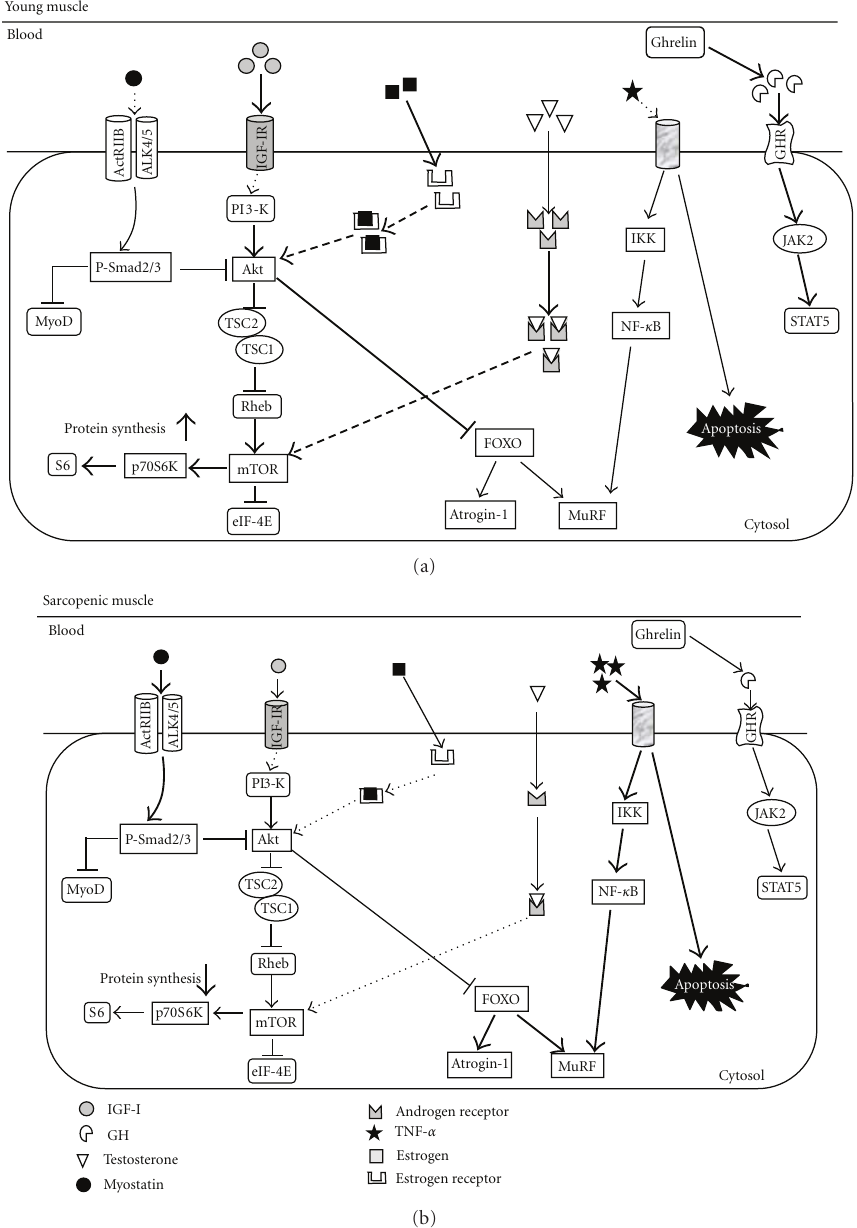
Figure 1: (a) In young muscle, abundant serum IGF-I can stimulate protein synthesis by activating Akt/mTOR/p70S6K pathway. Akt blocks the nuclear translocation of FOXO to inhibit the expression of Atrogin-1 and MuRF and the consequent protein degradation. Abundant serum GH, which is induced by ghrelin, activates JAK2-STAT5 signaling to promote muscle-specific gene transcription necessary to hypertrophy. In young muscle, testosterone and estrogen bind these intramuscular receptors (androgen receptor and estrogen receptor ( α and β )), and activate mTOR and Akt, respectively. Lower serum amount of myostatin and TNF- α failed to activate signaling candidates (Smad 2/3, NF- κ B, etc.) enhancing protein degradation. (b) In sarcopenic muscle, myostatin signals through the activin receptor IIB (ActRIIB), ALK4/5 heterodimer seems to activate Smad2/3 and blocking of MyoD transactivation in an autoregulatory feedback loop. Abundant activated Smad2/3 inhibit protein synthesis probably due to blocking the functional role of Akt. The increased blood TNF- α elevates the protein degradation through IKK/NF- κ B signaling and enhance an apoptosis. Lower serum amount of IGF-I, GH, and anabolic hormones (testosterone and estrogen) failed to activate signaling candidates (Akt, mTOR, STAT5, etc.) enhancing protein synthesis. The impaired regulation of FOXO by Akt results in abundant expression of Atrogin-1 and MuRF and the consequent protein degradation in sarcopenic